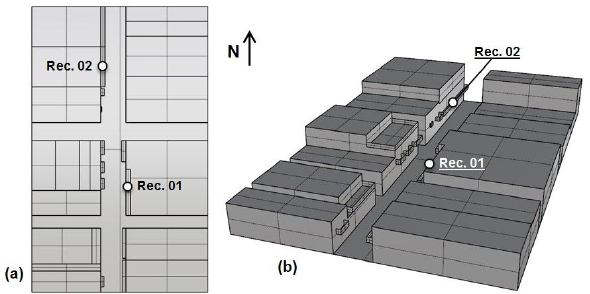
Figure 10: Geometry of the site modelled in Rhinoceros. (a) Plan; (b)